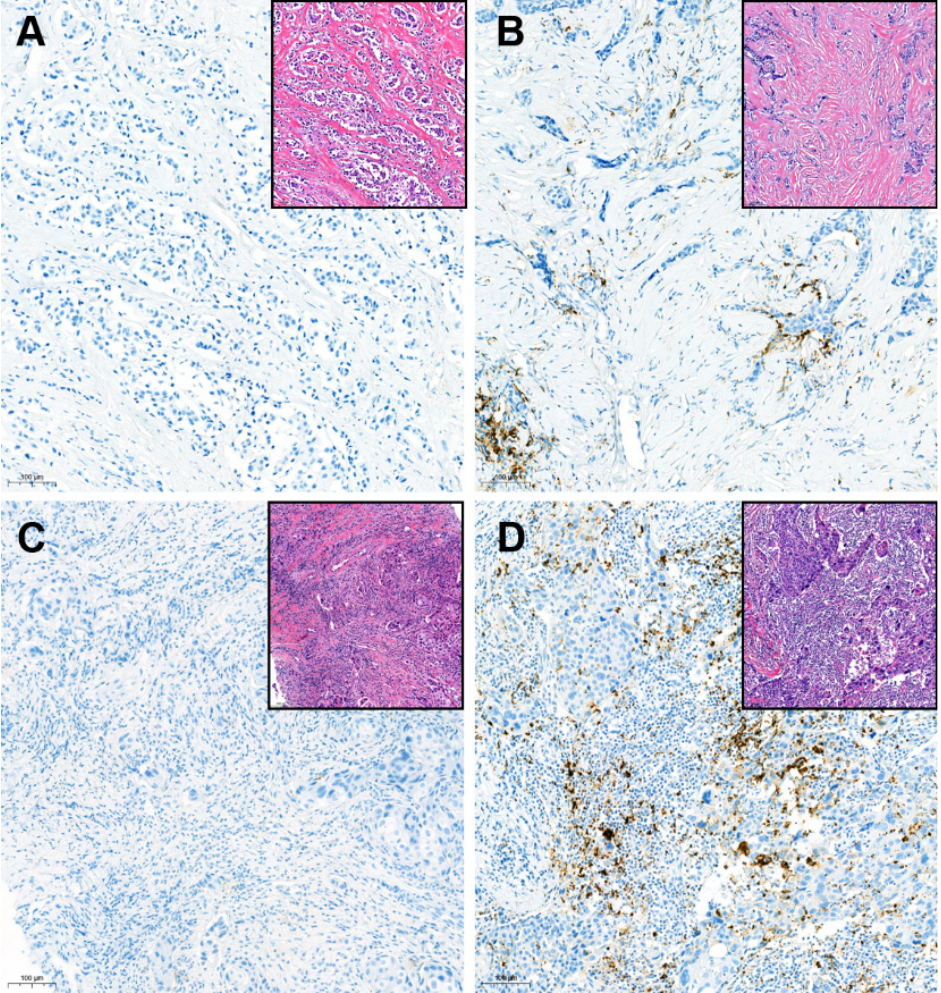
Figure 2. Representative cases for SP142 PD-L1 immunohistochemistry in tumors with variable tumor-infiltrating lymphocytes levels ( × 100 magnification): ( A ) Negative PD-L1 in the low-tumor-infiltrating lymphocyte (TIL) tumor; ( B ) Positive PD-L1 in the low-TIL tumor; ( C ) Negative PD-L1 in the high-TIL tumor; ( D ) Positive PD-L1 in the high-TIL tumor; Inlet pictures present the matched area of H&E images. The cutoff of TIL for the low- and high-TIL groups was defined as 20% in this